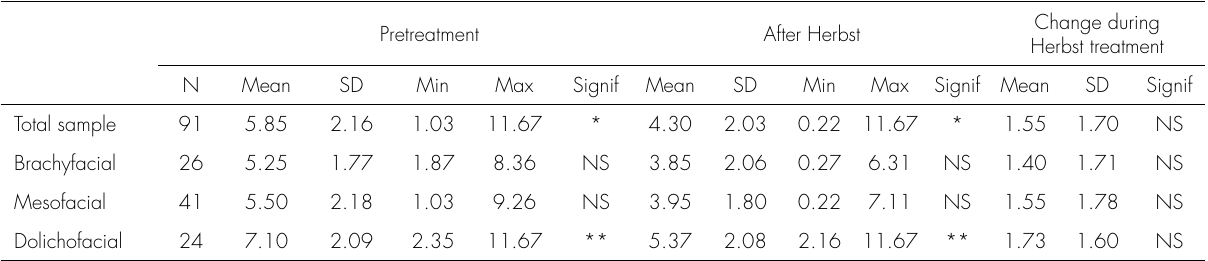
SD = Standard deviation, Min = minimum value, Max = maximum value, Signif = ANOVA, significant differences in means, NS = Not significant. * = p ≤ 0.05 ** = p ≤ 0.05, significant difference in vertical pattern subgroup